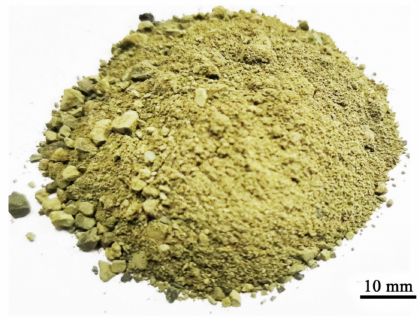
Figure 1. Photo of